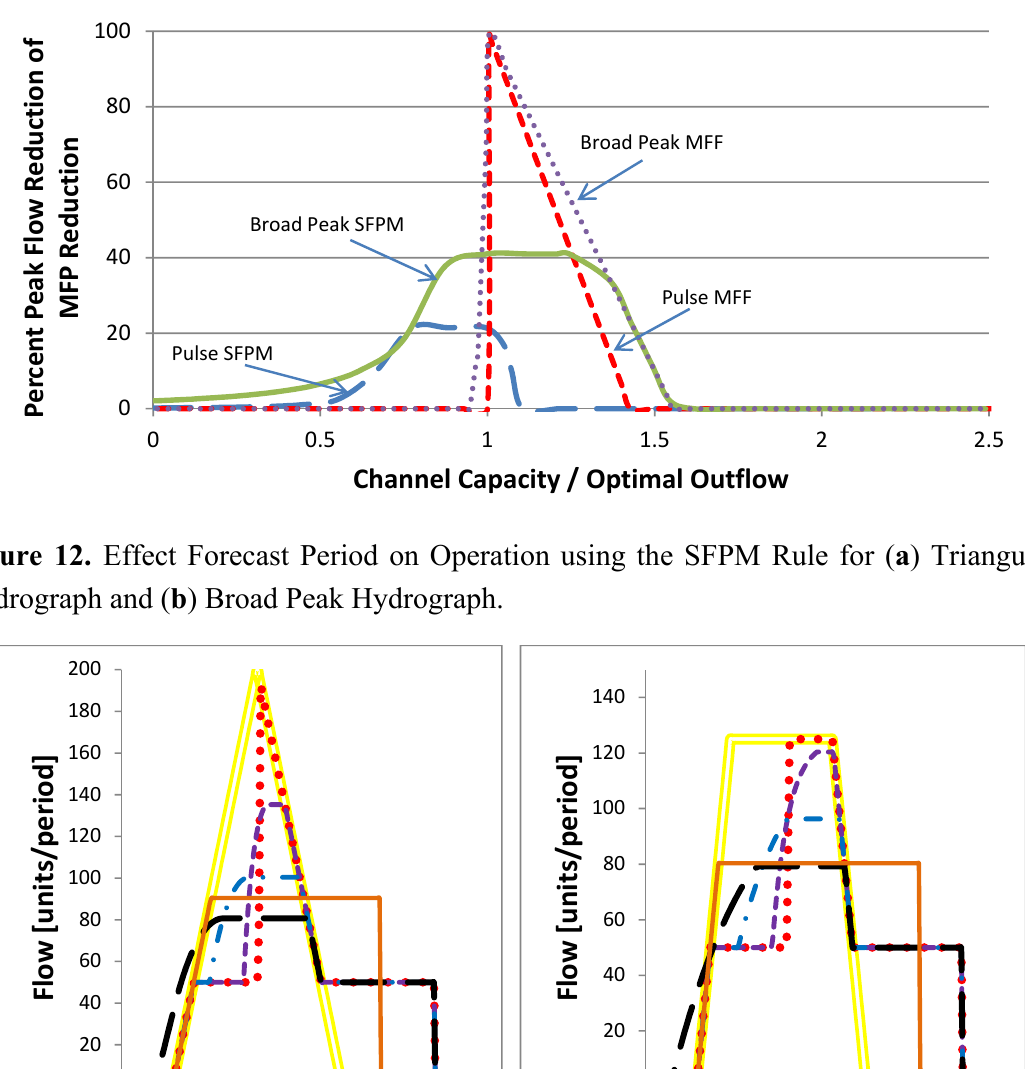
Figure 11. Comparison of Minimize Flood Frequency (MFF) and Short Forecast Peak Minimization (SFPM) rules for Flood Pulse and Broad Peak Hydrographs.